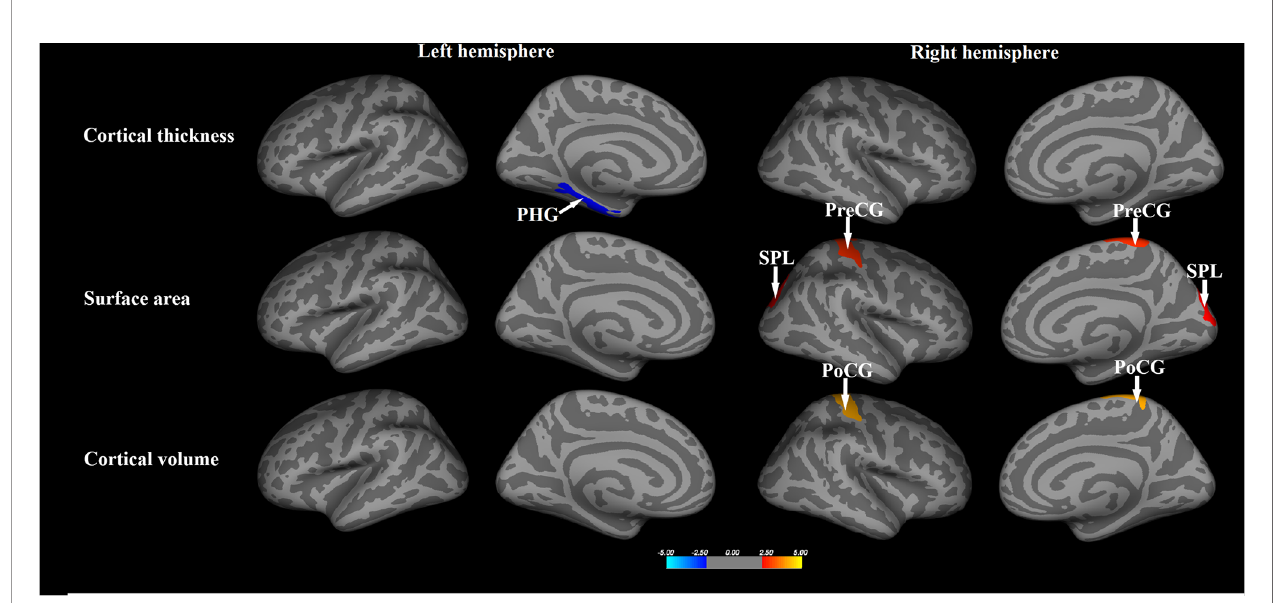
FIGURE 1 | The whole brain comparisons of the cortical thickness, surface area and volume between patients with nasopharyngeal carcinoma and healthy comparisons. Orange or red clusters represent the NPC > HCs; blue clusters represent the NPC < HCs. PHG, parahippocampal gyrus; PreCG, precentral gyrus; PoCG, postcentral gyrus; SPL, superior parietal